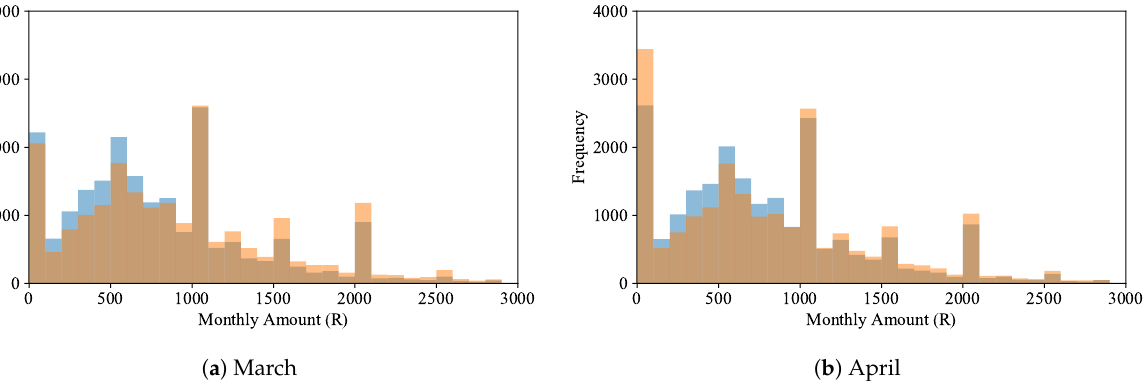
Figure 4. Histograms of the total household monthly amount purchased for electricity per prepaid meter for the control period (blue) and the lockdown period (orange). The overlap of histograms are shown in brown. Note: the behavioural analysis was performed using electricity units, and the monetary unit is reported here for reference